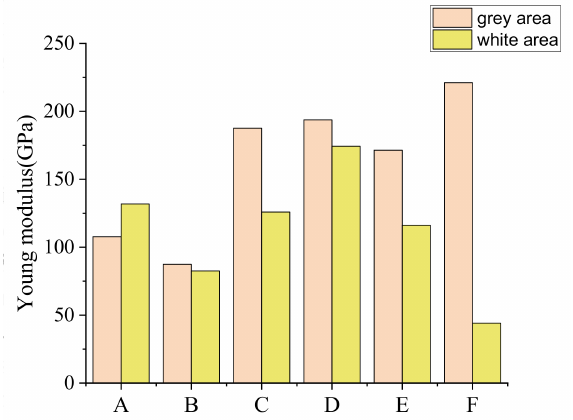
Figure 16. Young’s modulus test